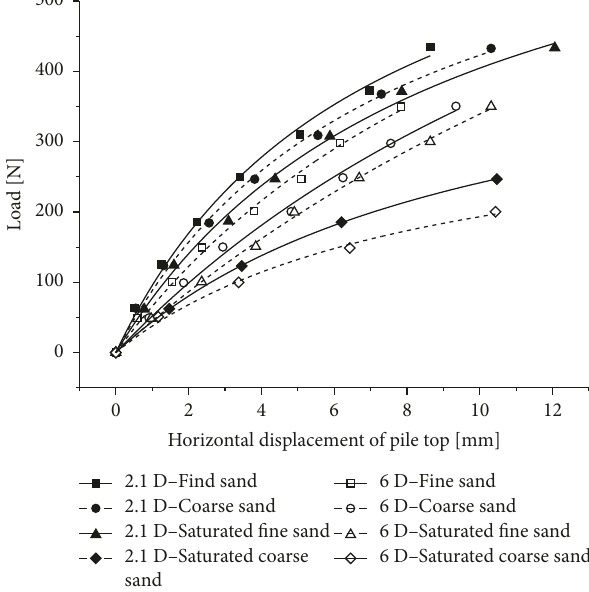
Figure 4: Horizontal displacement-load curve of pile top. Analysis of pile displacement and load.